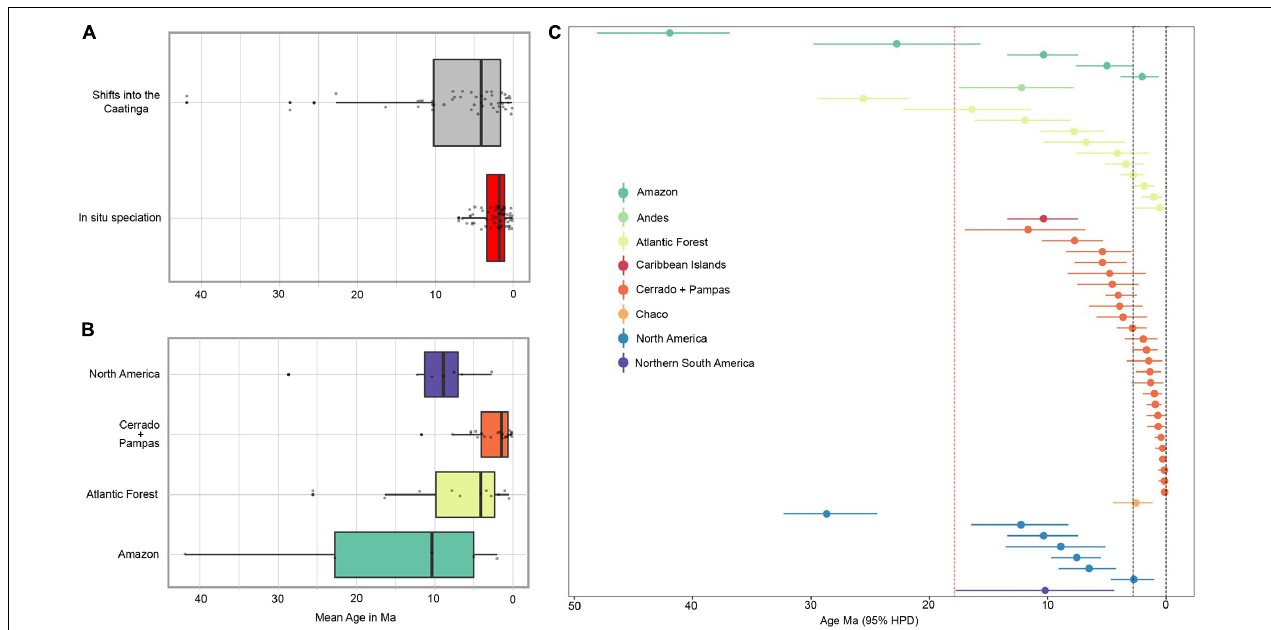
FIGURE 4 | Temporal patterns of biogeographical events generating Caatinga endemic lineages. Boxplots summarize ages for nodes with (A) highest probabilities of cladogenetic shifts into the Caatinga and in situ speciation and; (B) cladogenetic shifts from regions that are important providers of lineages to the Caatinga. (C) Node ages and confidence intervals of cladogenetic shifts (both dispersal and vicariance) leading to Caatinga crown clades as estimated by a DEC + j model. Ages are in decreasing order and grouped by inferred ancestral areas. Colors correspond to the same shown in Figure 3 . Vertical dotted red line represents the onset of uplift and erosion at 18–15 Ma according to Japsen et al. (2012). Vertical dotted black lines indicate the Pleistocene